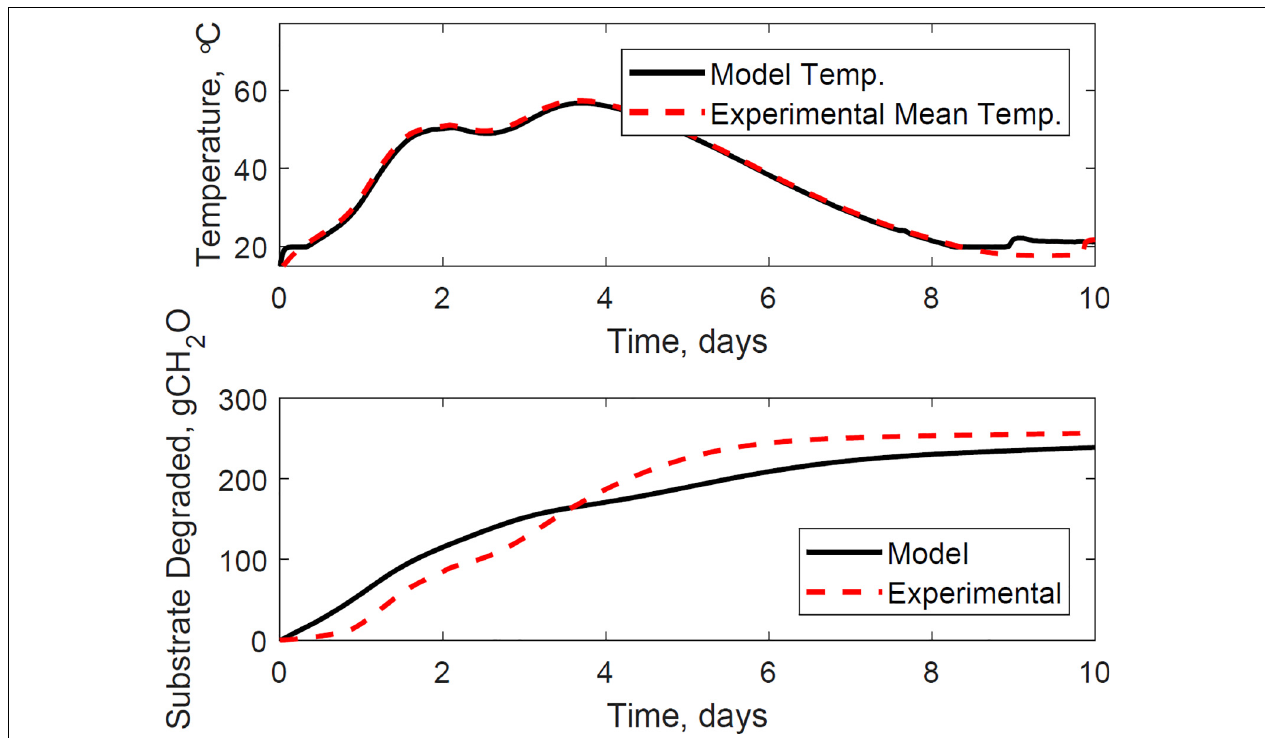
FIGURE 10 | Reactor 3 temperature (top) and substrate degraded (bottom) validation of system dynamics model. The model inputs are 1265 cc.min − 1 airflow rates, 29% initial moisture content, 18% final moisture content, 24 ◦ C ambient temperature. The initial model conditions are 13.8 ◦ C and 7071 g. The temperature mean absolute error is 1.1 ◦ C, and the dry matter loss relative error is